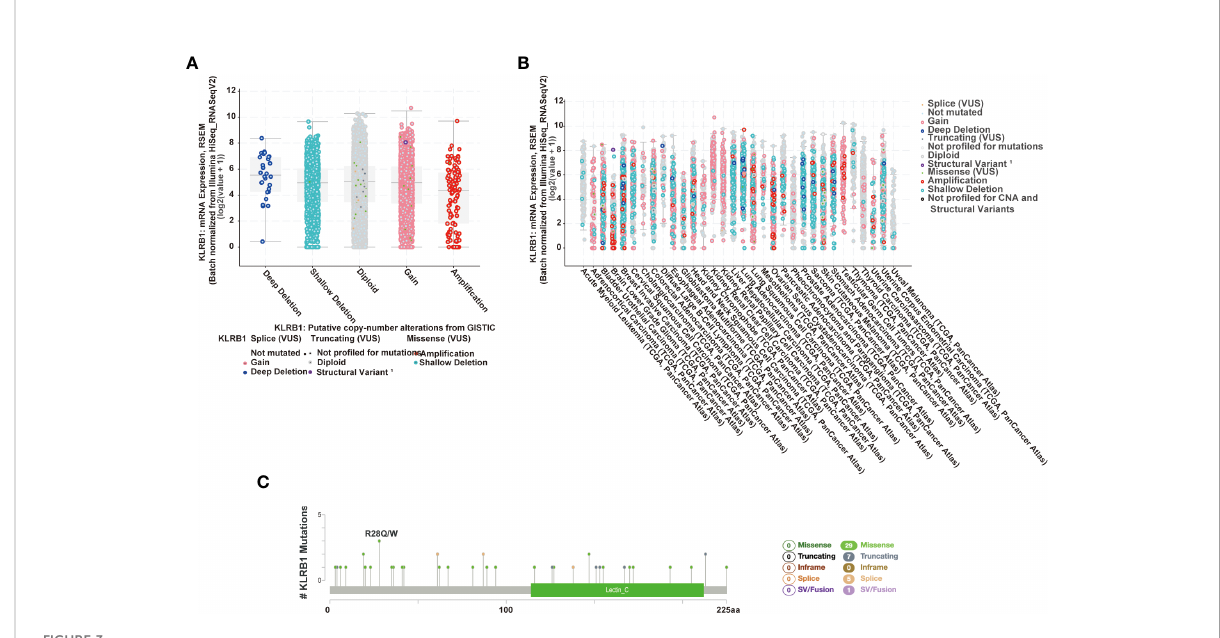
FIGURE 3 CD161 mutation landscape. The putative copy-number alterations from GISTIC of CD161 in many TCGA cancers by the cBioPortal database (A) . The study of the origin of CD161 in many TCGA cancers by the cBioPortal database (B) . Diagram of CD161 mutations across cancer types in the protein domain (C)